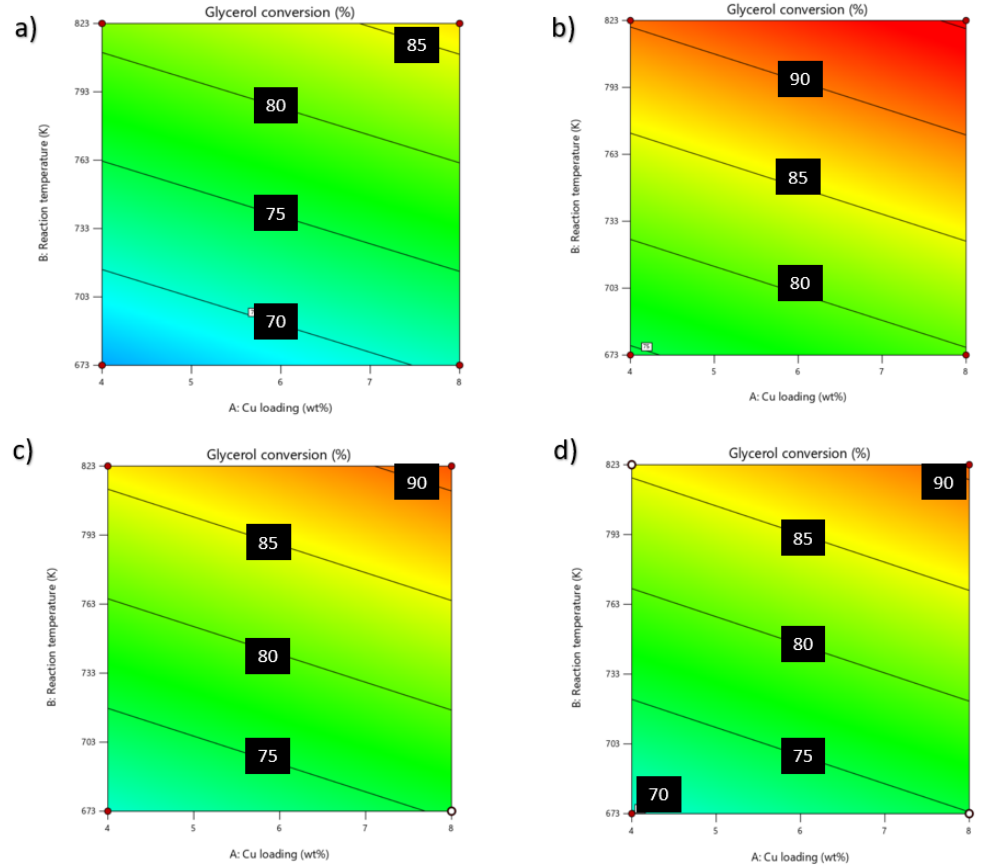
Figure 2. Counter plot for Y1 on reaction temperature vs. Cu loading: ( a ) WHSV and glycerol concentration are in minimum conditions; ( b ) WHSV and glycerol concentration are in maximum conditions; ( c ) WHSV is at minimum and glycerol concentration is at maximum; and ( d ) WHSV is at maximum and glycerol concentration is at minimum. (The black box indicates that the highest glycerol conversion can be obtained in the selected boundaries.)